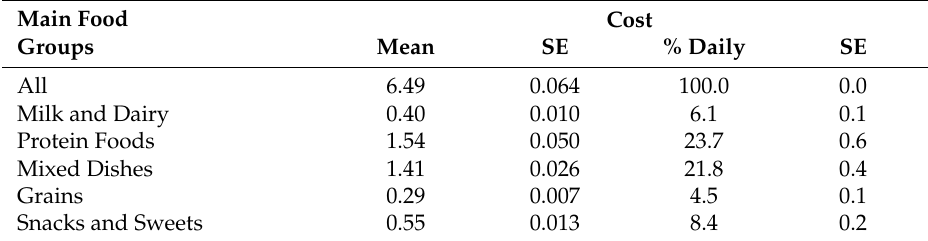
Table 5. Estimated percentage of adults, age ≥ 19 years, who consume specified food groups on a given day, and the estimated mean daily cost ($) of each food group expressed in dollars, and as a percentage of the total cost of